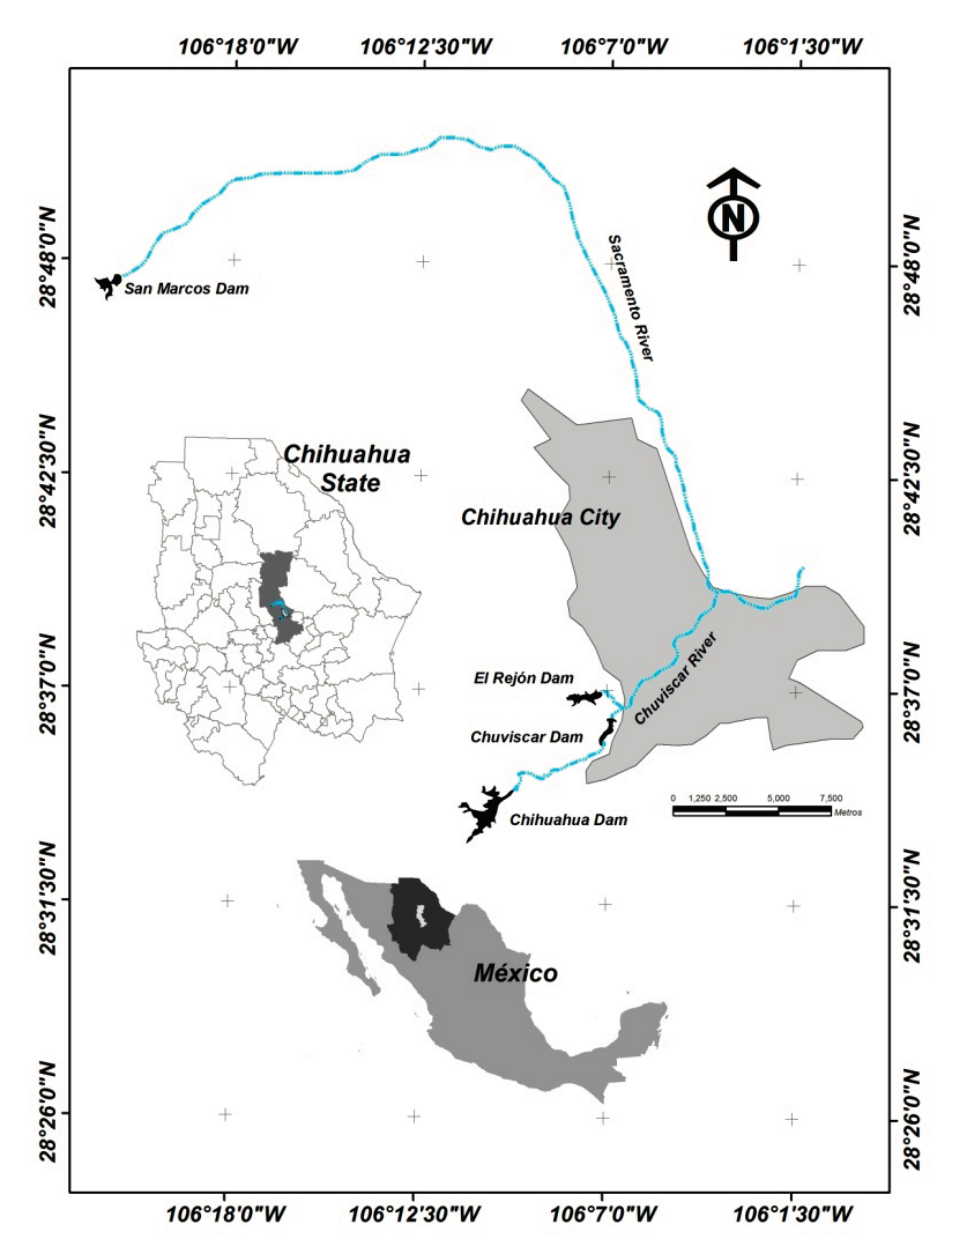
Figure 1. Location map of the water reservoirs in Chihuahua County,